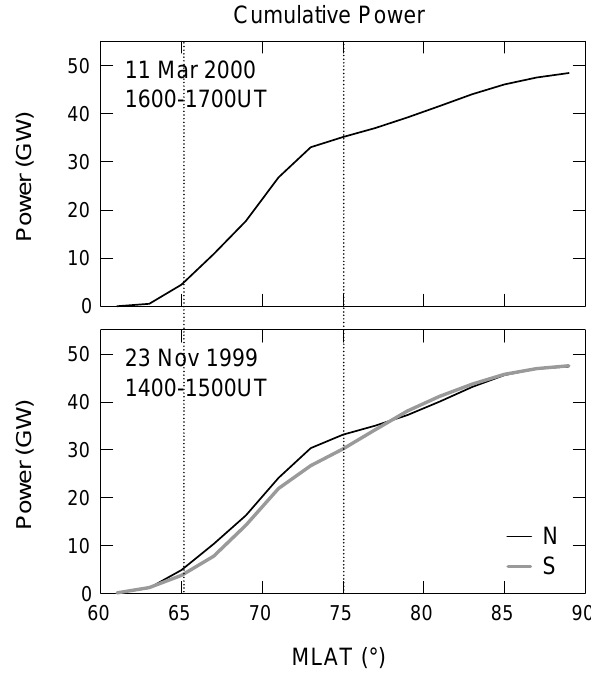
Fig. 7. Auroral zone power in GW per hour of MLT versus local time for (top) 11 March 2000 and (bottom) 23 November 1999.